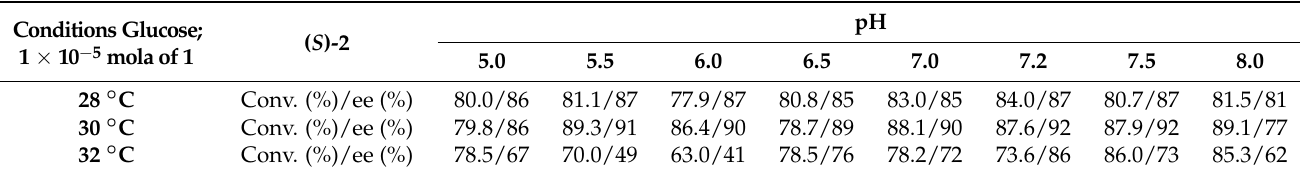
Table 3. The Efficiency and Enantioselectivity of the Bioconversion of 1 at 28 ◦ C, 30 ◦ C and 32 ◦ C by A. pullulans Strain DSM 14940 and DSM 14941.